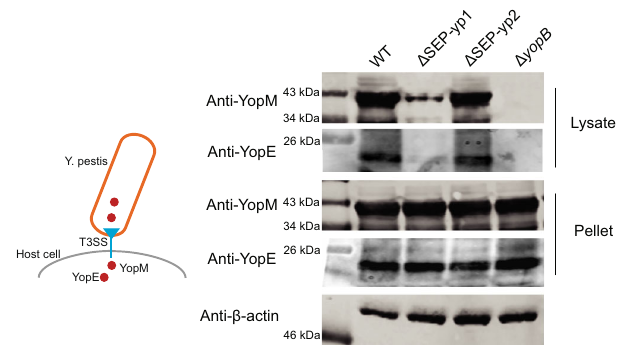
Fig. 6 Deletion of SEP-yp1 in fl uences the translocation of T3SS. HeLa cells were infected with Y. pestis strains for 2 h. After removing the media and thoroughly washing the wells, the infected cells were lysed by Triton X-100 buffer, since it is unable to break the cell wall of bacteria. The mixture was centrifuged to separate the lysate and the cell debris pellet. The samples were immunoblotted. Each assay has three